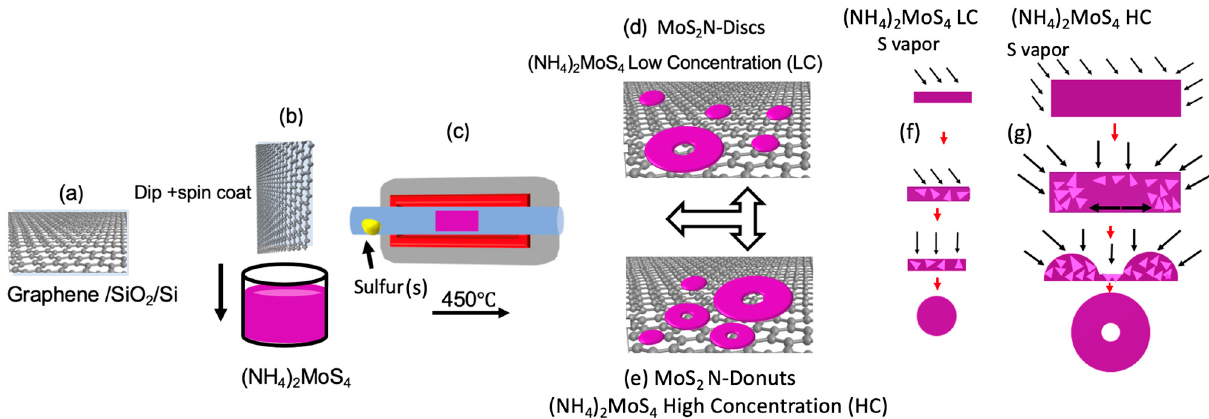
Figure 1. Schematic description of the synthesis process ( a ) graphene transferred on SiO 2/ Si substrates via a wet transfer procedure ( b , c ) MoS 2 on graphene using the vapor transport process. ( d ) synthesis of the MoS 2 N-Discs with low concentrations of (NH 4 ) 2 MoS 4 precursor solution and ( e ) synthesis of the MoS 2 N-donuts with high concentrations of (NH 4 ) 2 MoS 4 precursor solution. The hypothetical growth mechanism MoS 2 N-discs at low ( f ) and MoS 2 N-Donuts at high ( g ) (NH 4 ) 2 MoS 4 precursor concentration, respectively. Triangles represent MoS 2 nuclei formed during the vapor transport annealing process.